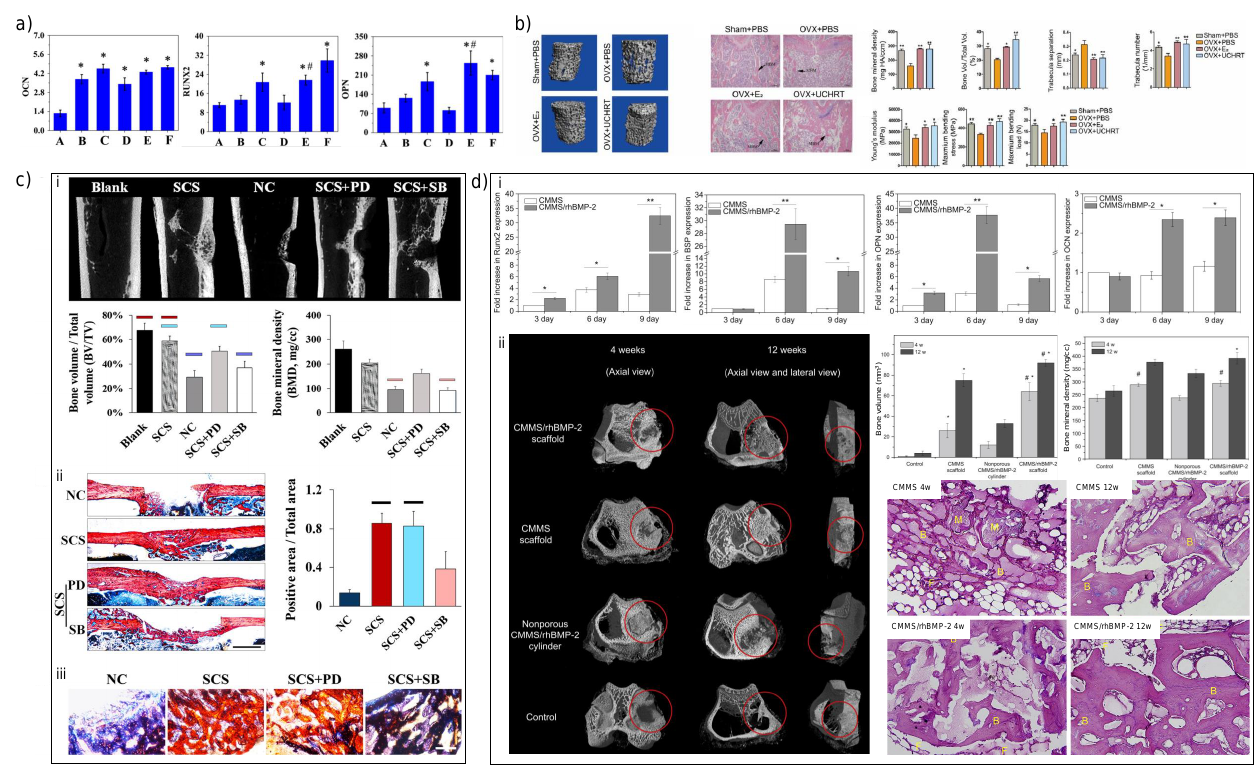
Figure 4. The application of nano silica in bone tissue engineering. ( a ) The effect of Si ions on osteogenesis-related gene expression of human bone marrow mesenchymal stem cells (BMSCs). A: blank control (DMEM); B: 10 µ g/mL Si ions in DMEM; C: 50 µ g/mL Si ions in DMEM; D–F: A–C solution plus 35 µ g/mL dimethyloxaloylglycine, respectively. *: Comparison between blank and other groups; #: comparison between group B and E, C and F, respectively; p < 0.05 [13]. ( b ) Mesoporous silica nanoparticles (MSNs) assisted E2 sustained release, which prevented osteoporosis in vivo. OVX = ovariectomy; UCHRT = NaLuF 4 :Yb,Tm@NaLuF 4 @mSiO 2 -EDTA-E2 nanocomposites. *: p < 0.05, **: p < 0.01 [42]. ( c ) Nano silica incorporated collagen fibrils promoted bone regeneration in rat femoral defects. SCS = silicified collagen scaffold; NC: negative control; SCS + PD: silicified collagen scaffold plus PD098059; SCS + SB: silicified collagen scaffold plus SB203580; PD and SB are MAPK inhibitors. ( i ) Micro-CT scans and quantitative results. ( ii ) van Geison staining. Bar = 1 mm. ( iii ) Ponceau trichrome staining. Bar = 200 µ m [52]. ( d ) The osteoconductivity of calcium/magnesium-doped rhBMP-2-incorporated MSN scaffold in vitro and in vivo. CMMS= calcium/magnesium-doped silica-based scaffolds. ( i ) rhBMP-2 increased the osteogenesis-related gene expression of rat BMSCs. ( ii ) CMMS/rhBMP-2 scaffold promoted bone regeneration in rabbit femoral defects as demonstrated by micro-CT analysis and histological evaluation. M: materials, B: bone, F: fibrous tissue. *: p < 0.05; #: p < 0.05